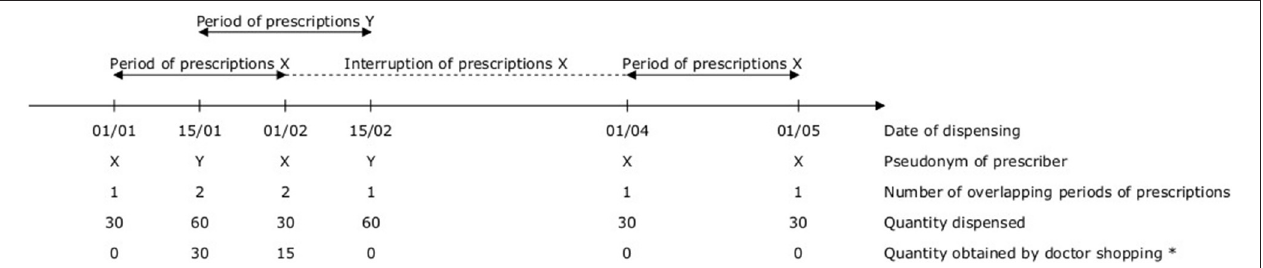
FIGURE 1 | Method to detect and quantify doctor shopping for prescription drugs, accounting for overlapping prescriptions. *The quantity obtained by doctor shopping is calculated as Qd–Qd/n, where Qd is the quantity dispensed, n is the number of overlapping periods of prescriptions, and Qd/n is the quantity that would have been dispensed with only one